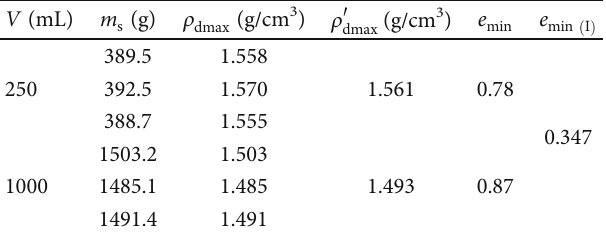
Figure 7: SEM scanning images of calcareous sands. Table 2: Maximum dry density and minimum void ratio under the volume of 250 and 1000 mL.